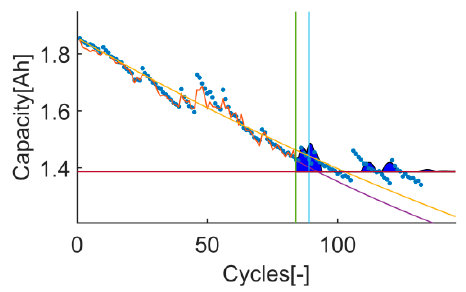
Figure 26. Time-instant figure of test 4 on t 78 .